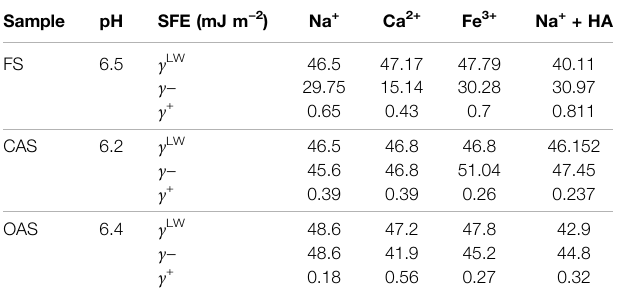
TABLE 3| Mineralogicalcomposition ofclayfraction (orientedaggregate. Mg-EG. % relative peak area). Sample